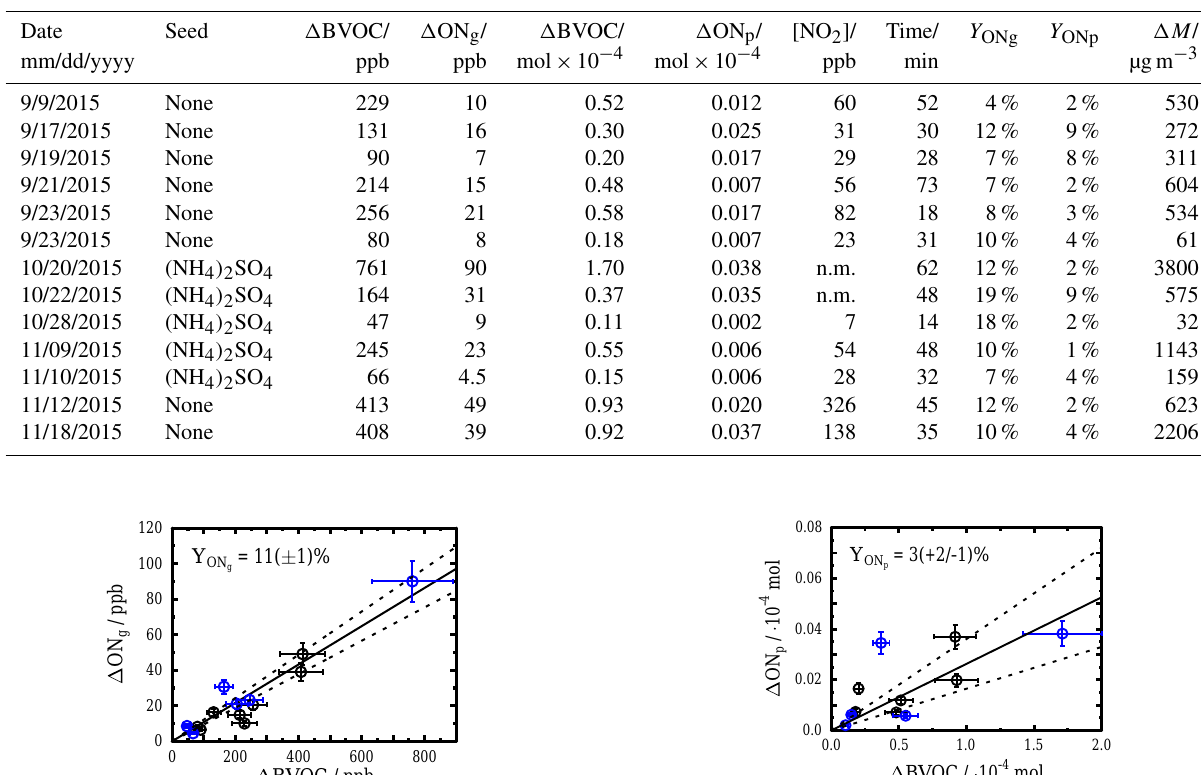
Table 1. Initial conditions and yields from individual experiments. Time indicates the period between N 2 O 5 addition to the chamber and gas and particle collection by the denuder and filter. “n.m.” indicates “not measured”.